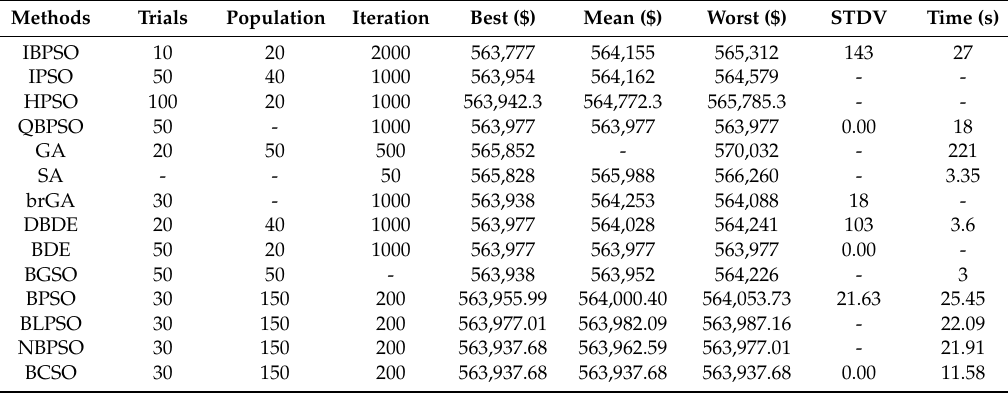
Figure 1. Optimal convergences using di ff erent algorithms for di ff erent unit numbers. Table 2. Comparison between BCSO and other algorithms.